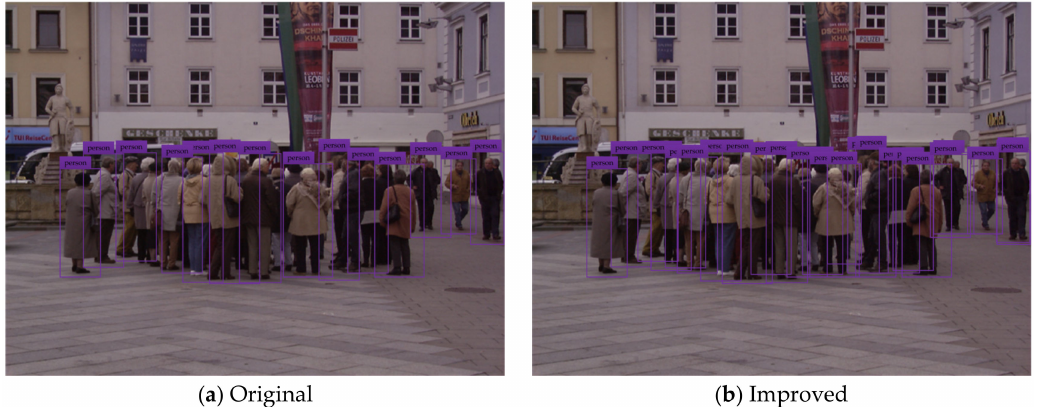
Figure 8. Pedestrian detection test results under complex background.